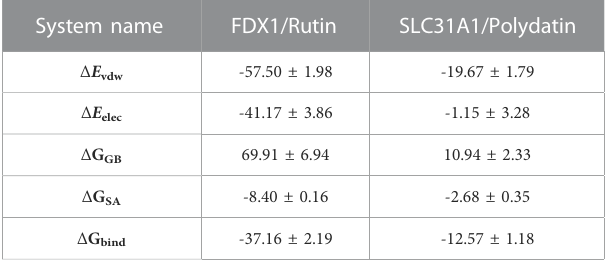
TABLE3BindingfreeenergiesandenergycomponentspredictedbyMM/GBSA